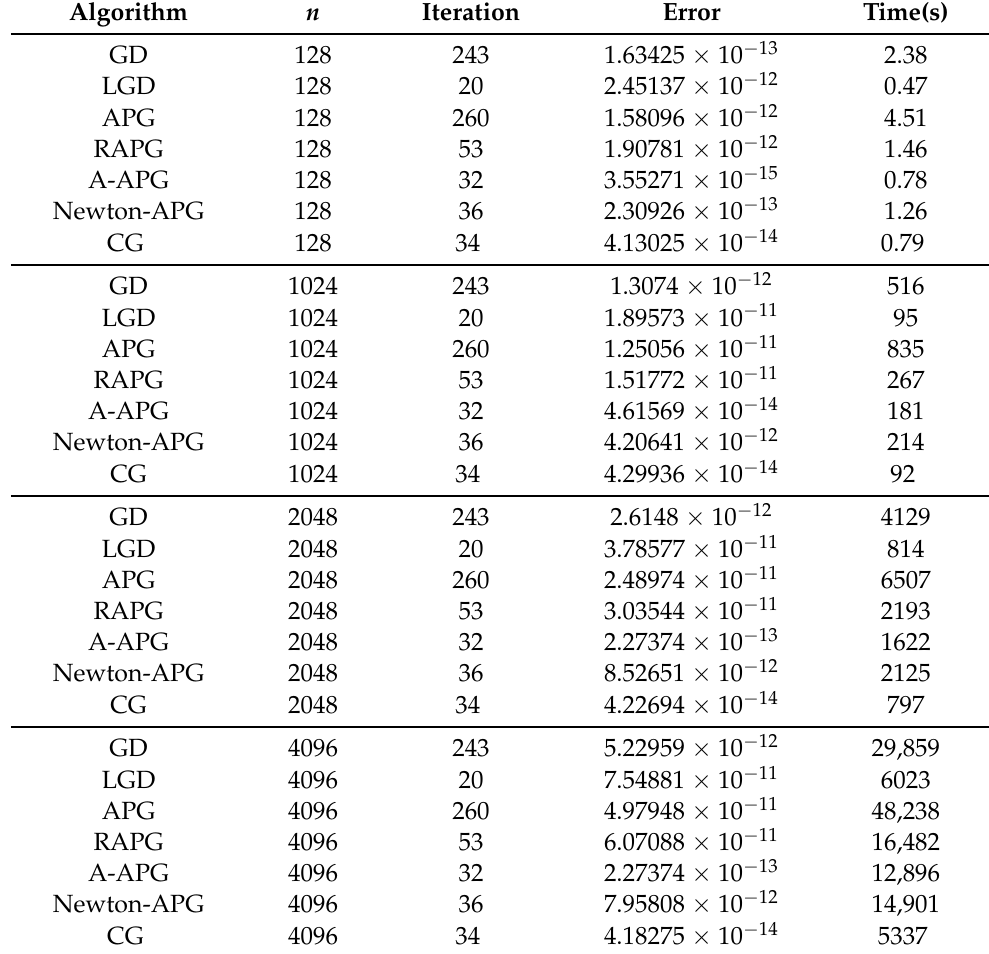
Table 2. Numerical results for Example